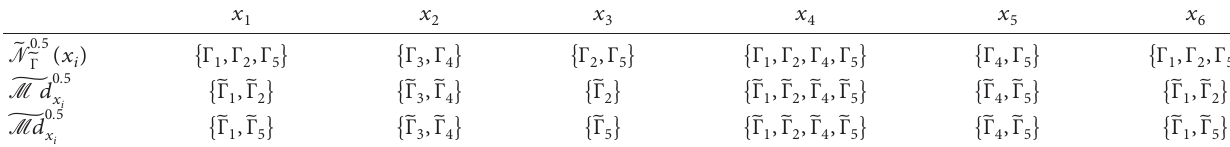
( x ) , 􏽧 M d β i x i , and C